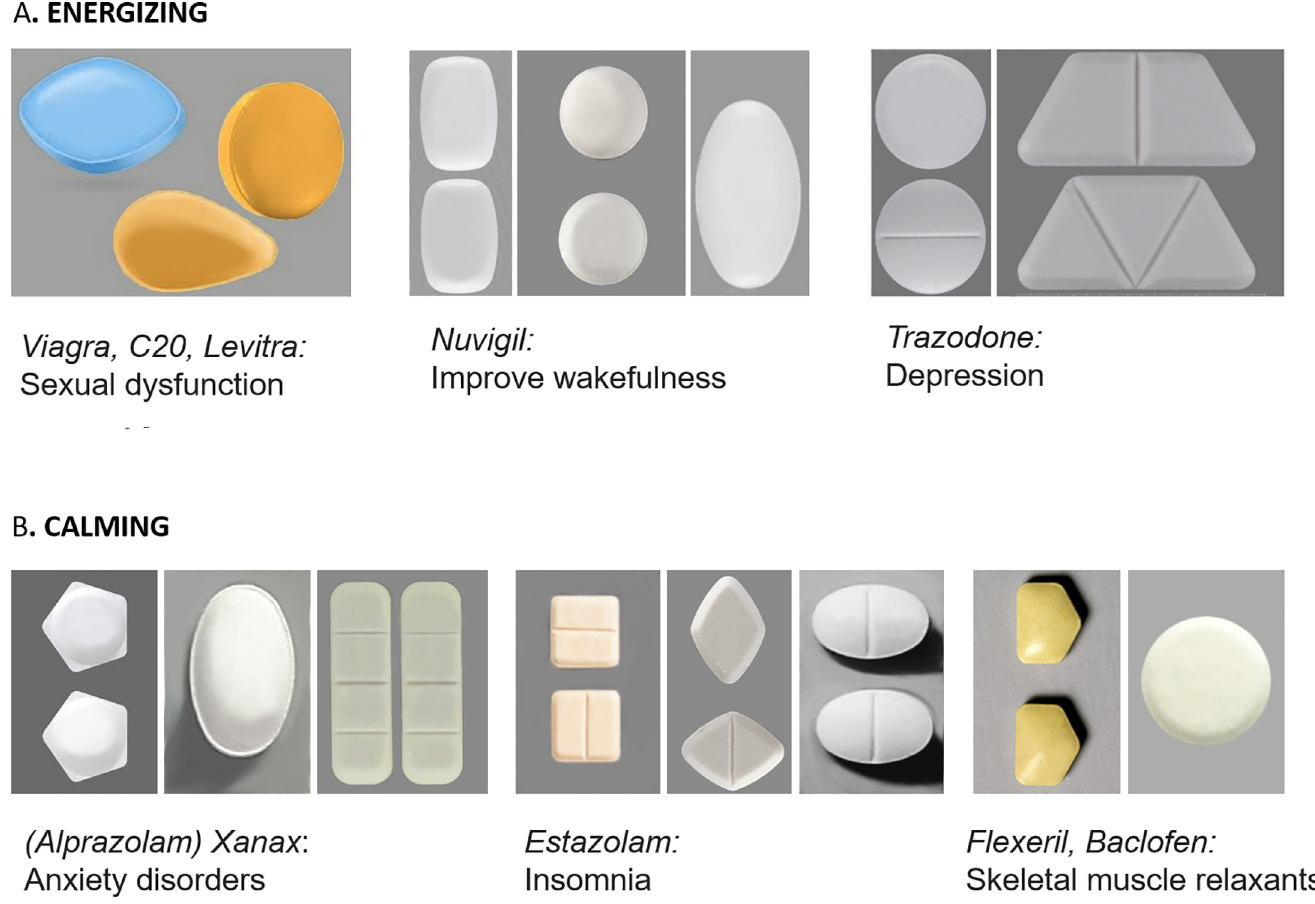
Fig 1. Examples of the existing angular vs. curvy